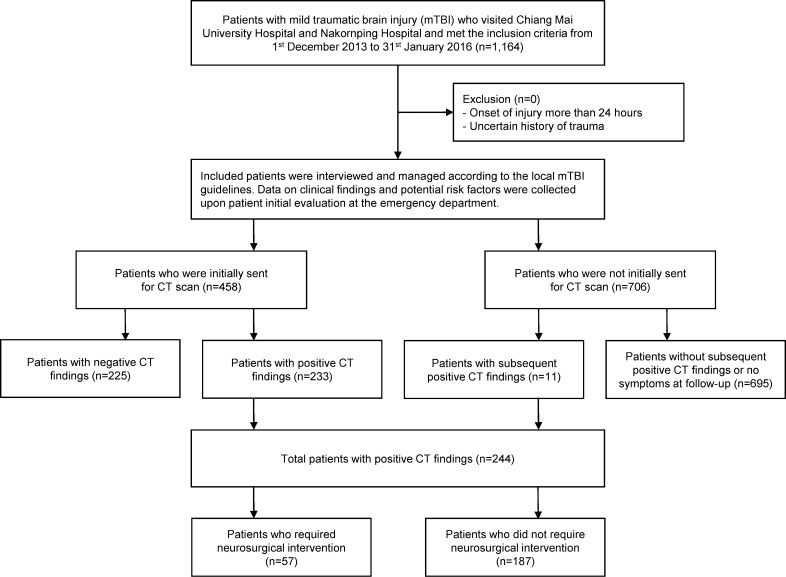
Patient flow diagram.